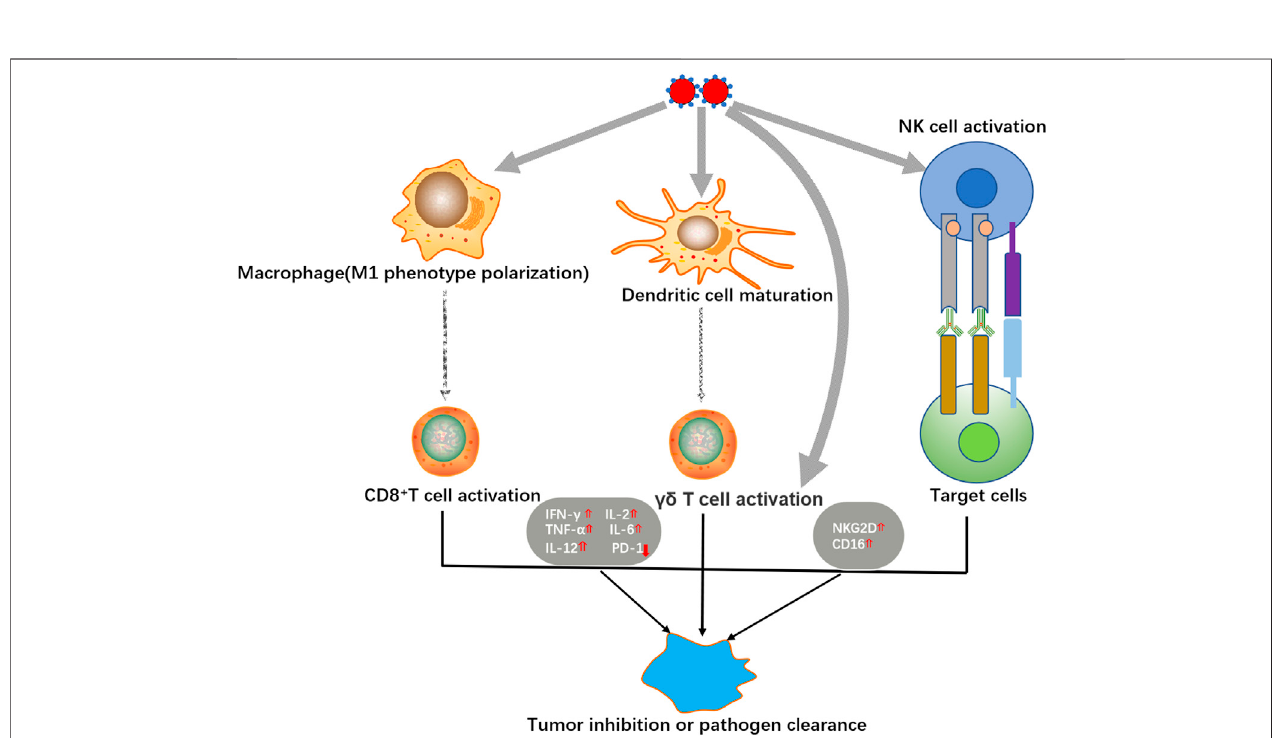
FIGURE 2 | Immunomodulation activities of Se NPs.